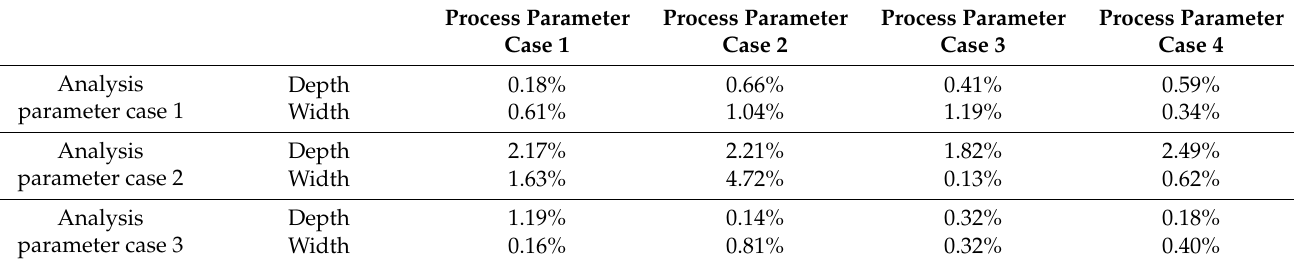
Figure 8. Sensitivity of analysis parameters for modified range to: ( a ) melt pool depth; ( b ) melt pool width. Table 6. Relative error in melt pool size between analysis model and regression